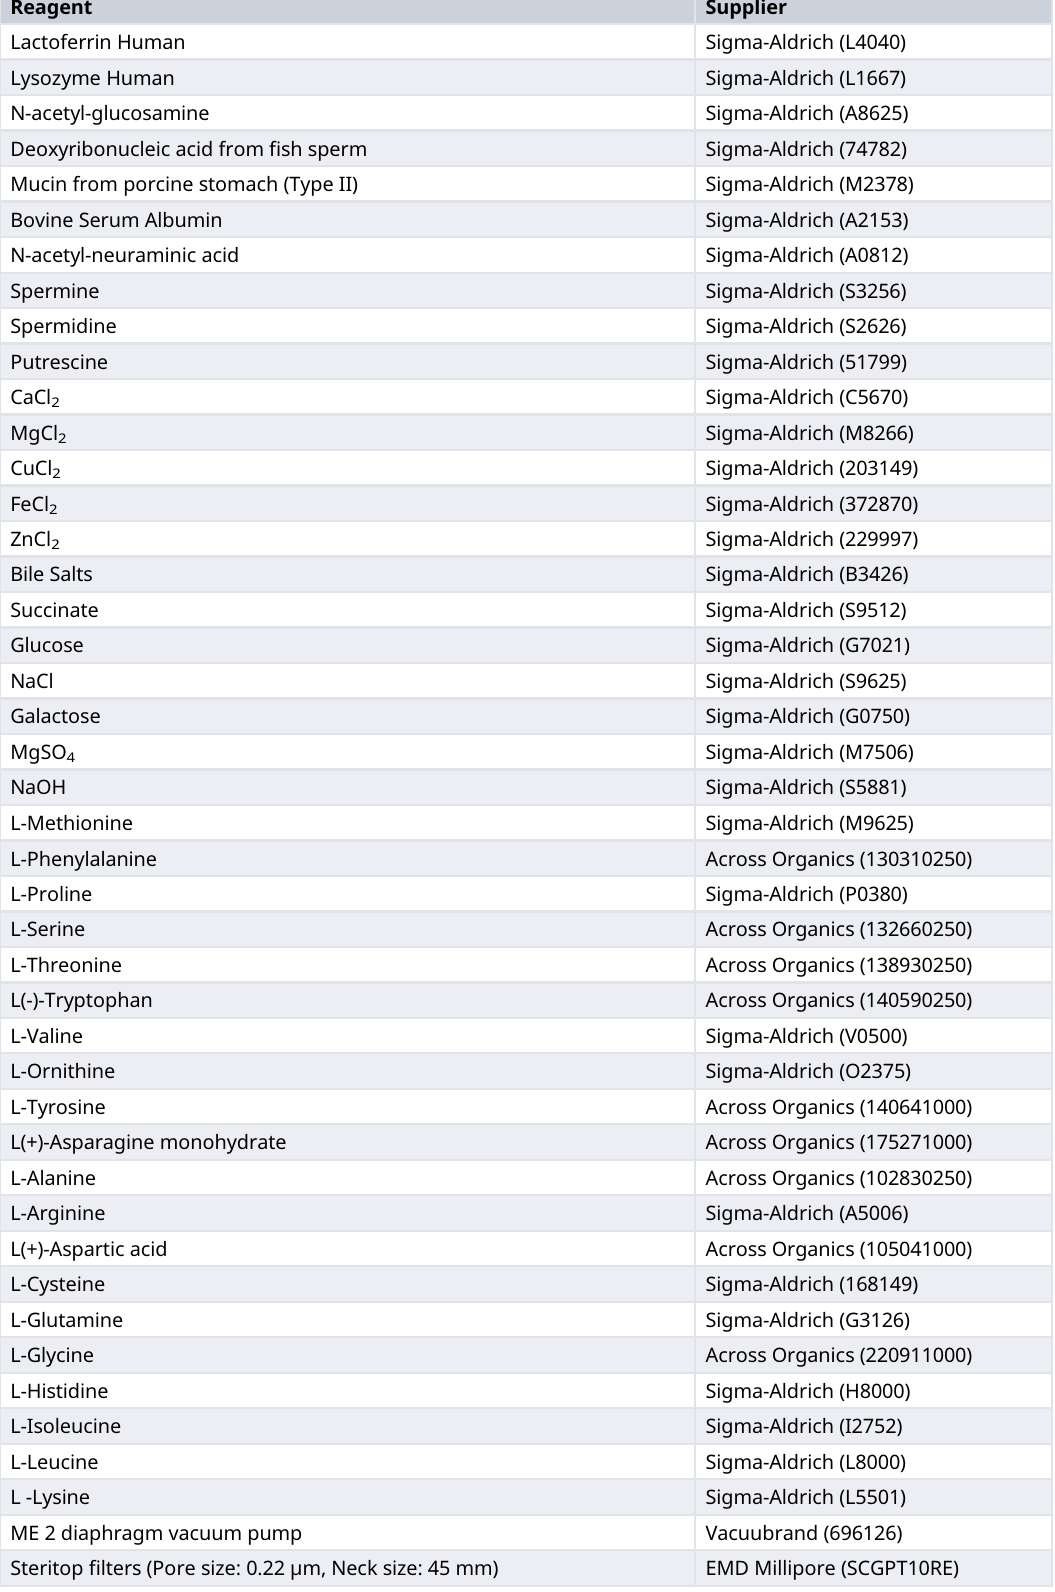
Table 16. Materials and Equipment used in the study and supplier